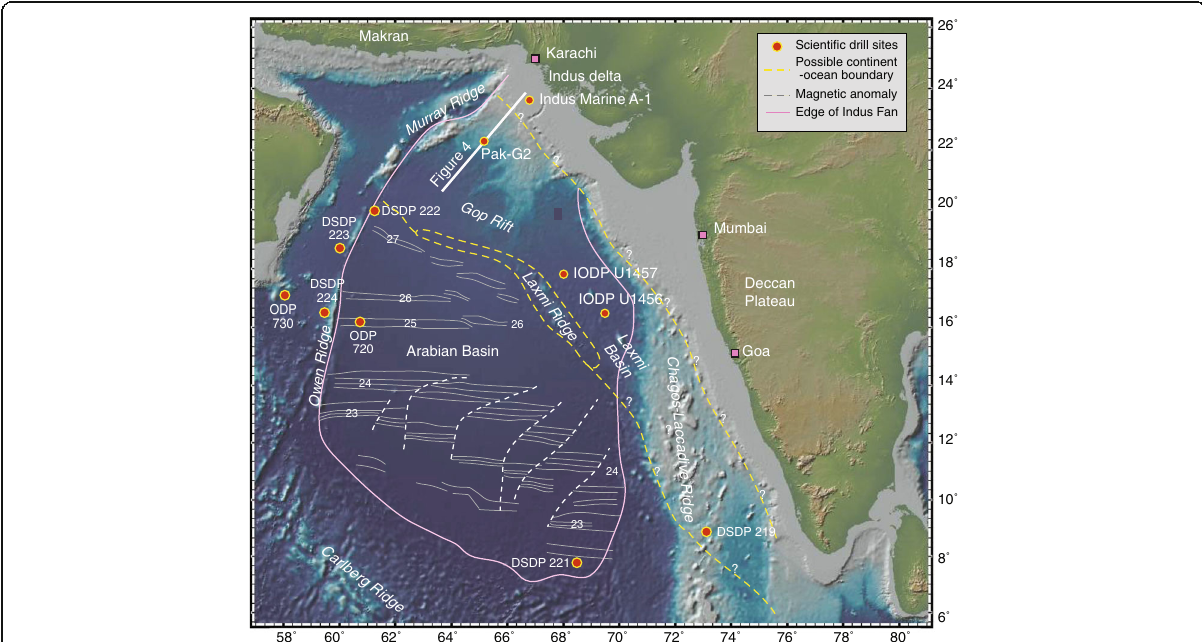
Fig. 2 Shaded bathymetric map of the Arabian Sea showing the extent of the Indus Fan (Kolla and Coumes 1987), the location of scientific and industrial boreholes discussed in this paper, and the main tectonic elements that bound the basin, especially the marine magnetic anomalies of Miles and Roest (1993). Base map is from